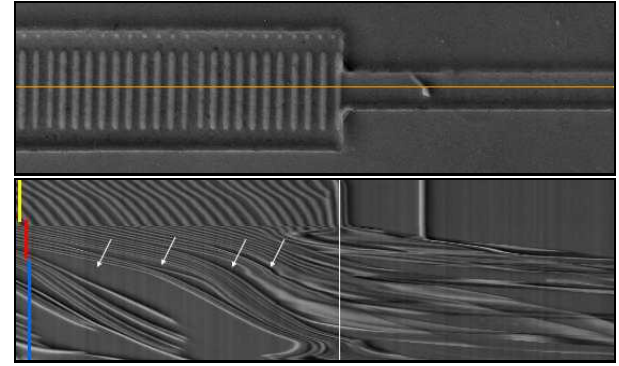
Figure 15. Spatio-temporal representation of a cut parallel to the flow direction. The top image is the first image of the whole image sequence of the fiber suspension shown in Figure 14. The orange line indicates the cut used to build the spatio-temporal representation of the image sequence shown below. Here, time goes from top to bottom (total duration around 12 s), and the horizontal axis corresponds to the orange line drawn in the picture above. The position of the constriction is indicated in white, and the colored lines indicate the start and duration of corresponding sets of images shown in Figure 14. In this representation, cluster formation upstream of the restriction can be easily seen. The white arrows indicate empty spaces separating clusters.